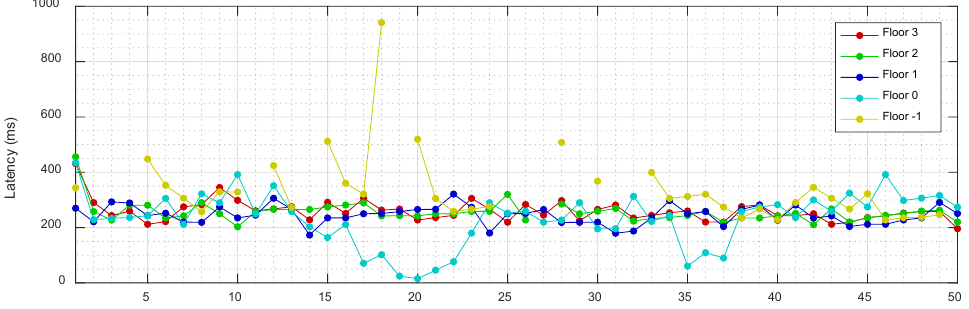
Figure 14. Evolution of the latency of the IoT device.